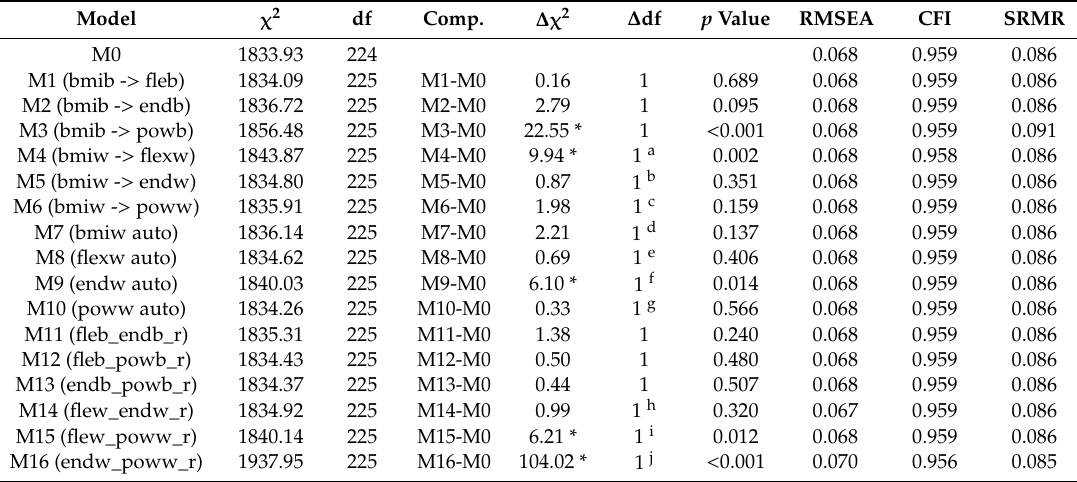
Table 4. Fit indices for a multi-group random-intercept panel model (RIPM) of sex for overweight and normal weight